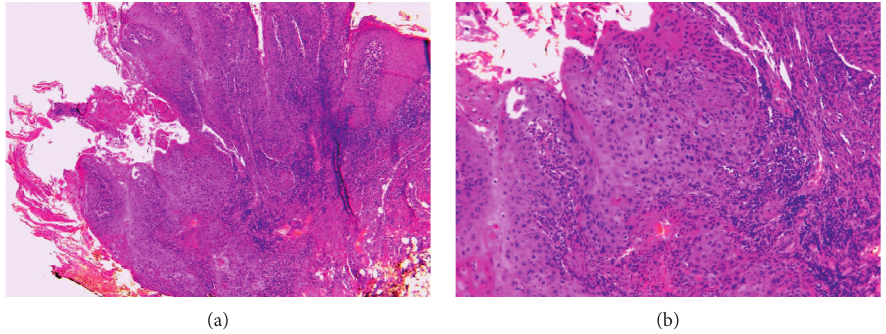
Figure 2: Histological sections: infiltrating carcinomatous proliferation showing squamous differentiation of the labial mucosa (a) small lesion, H&E: 40; (b) large lesion, H&E: